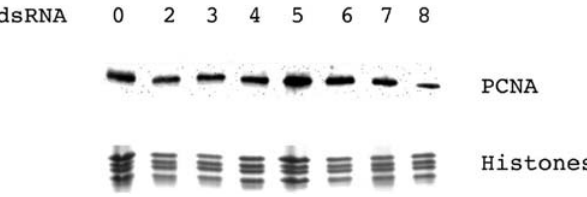
Figure 7. Immunoblot to show the effect of MCM depletions on the levels of PCNA bound to chromatin. Coomassie stained histones are included as a loading control. The amount of PCNA was compared to the histones using Alpha Innotech imager software. Horizontal numbers show the MCM protein targeted by RNAi.